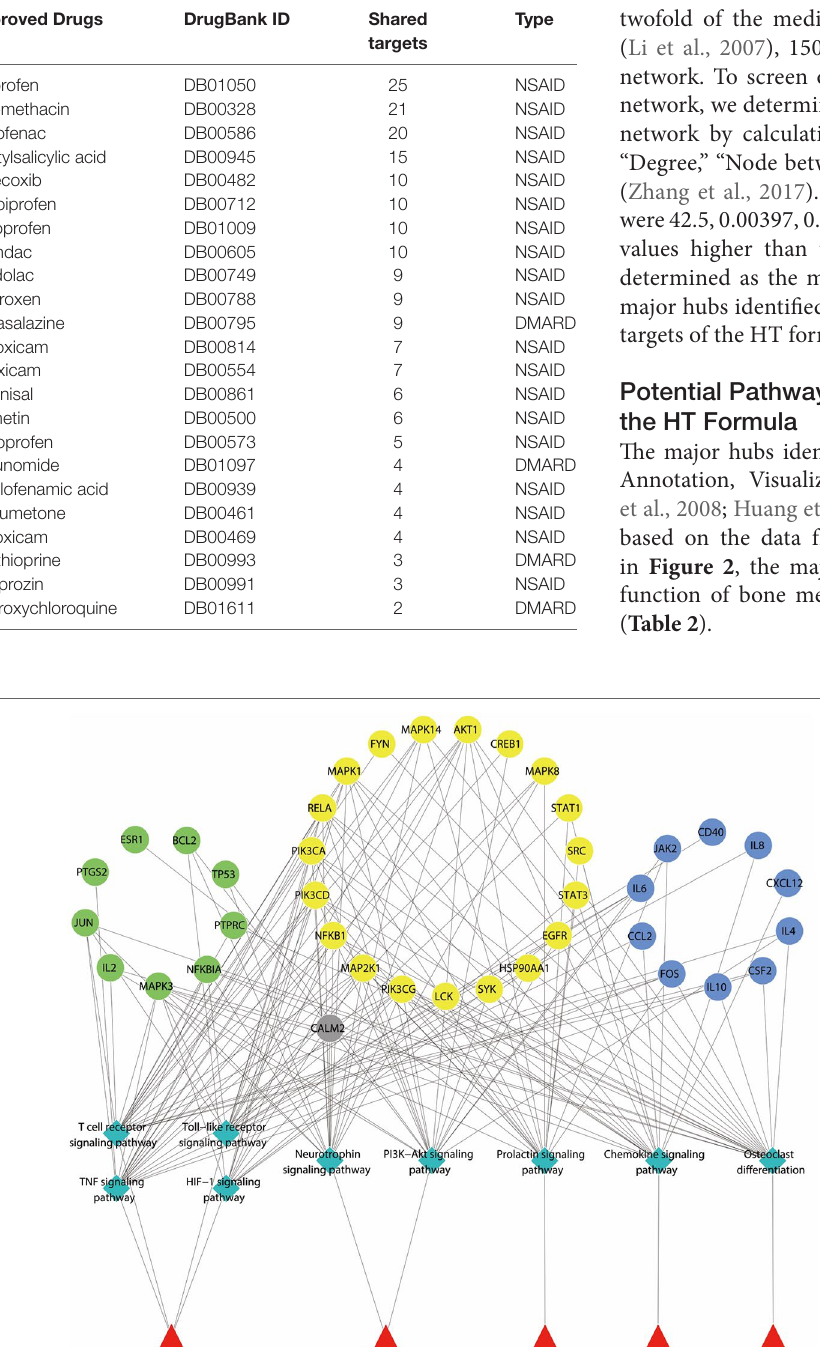
TABLE 1 | List of the approved disease-modifying antirheumatic drugs (DMARDs) and nonsteroidal anti-inflammatory drugs (NSAIDs) sharing common targets with the Huayu-Qiangshen-Tongbi (HT) formula.